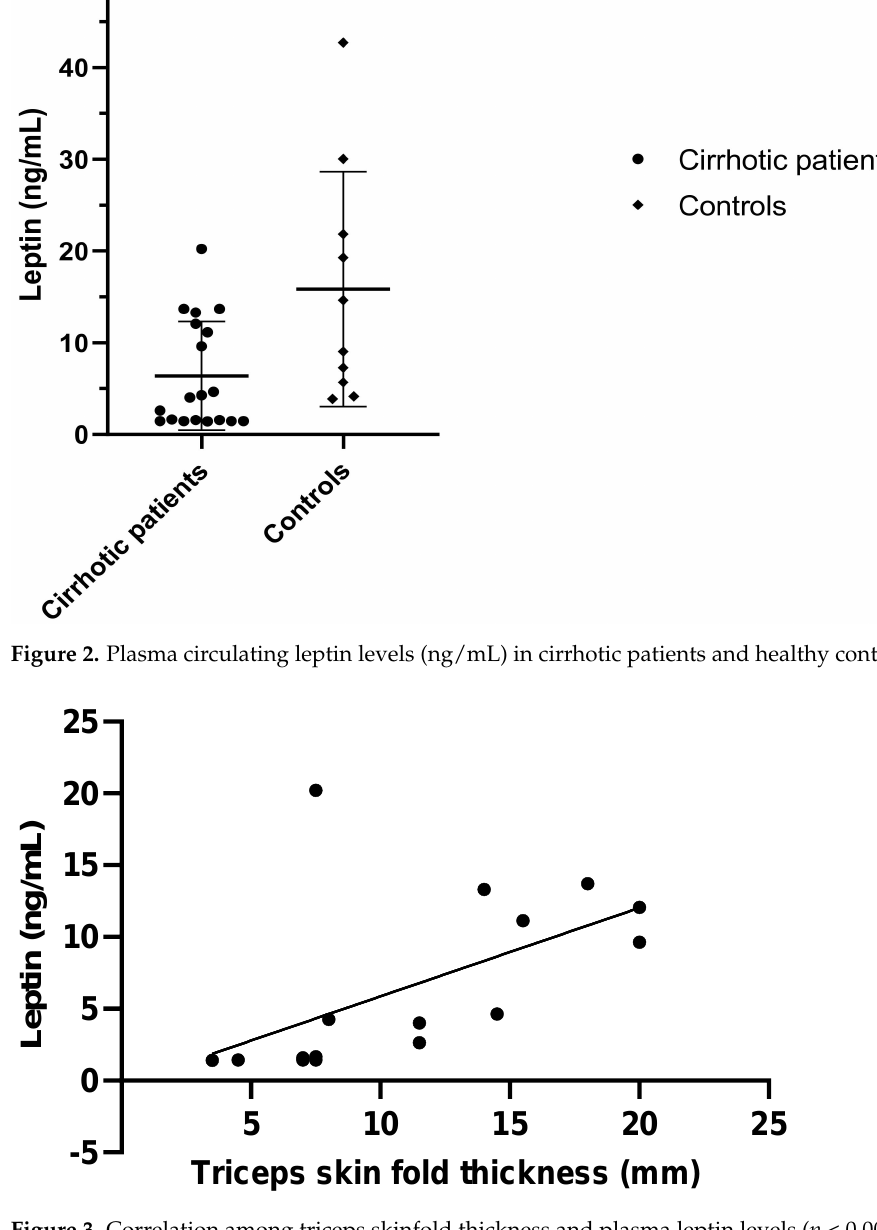
Figure 3. Correlation among triceps skinfold thickness and plasma leptin levels ( p < 0.001; r = 0.76).